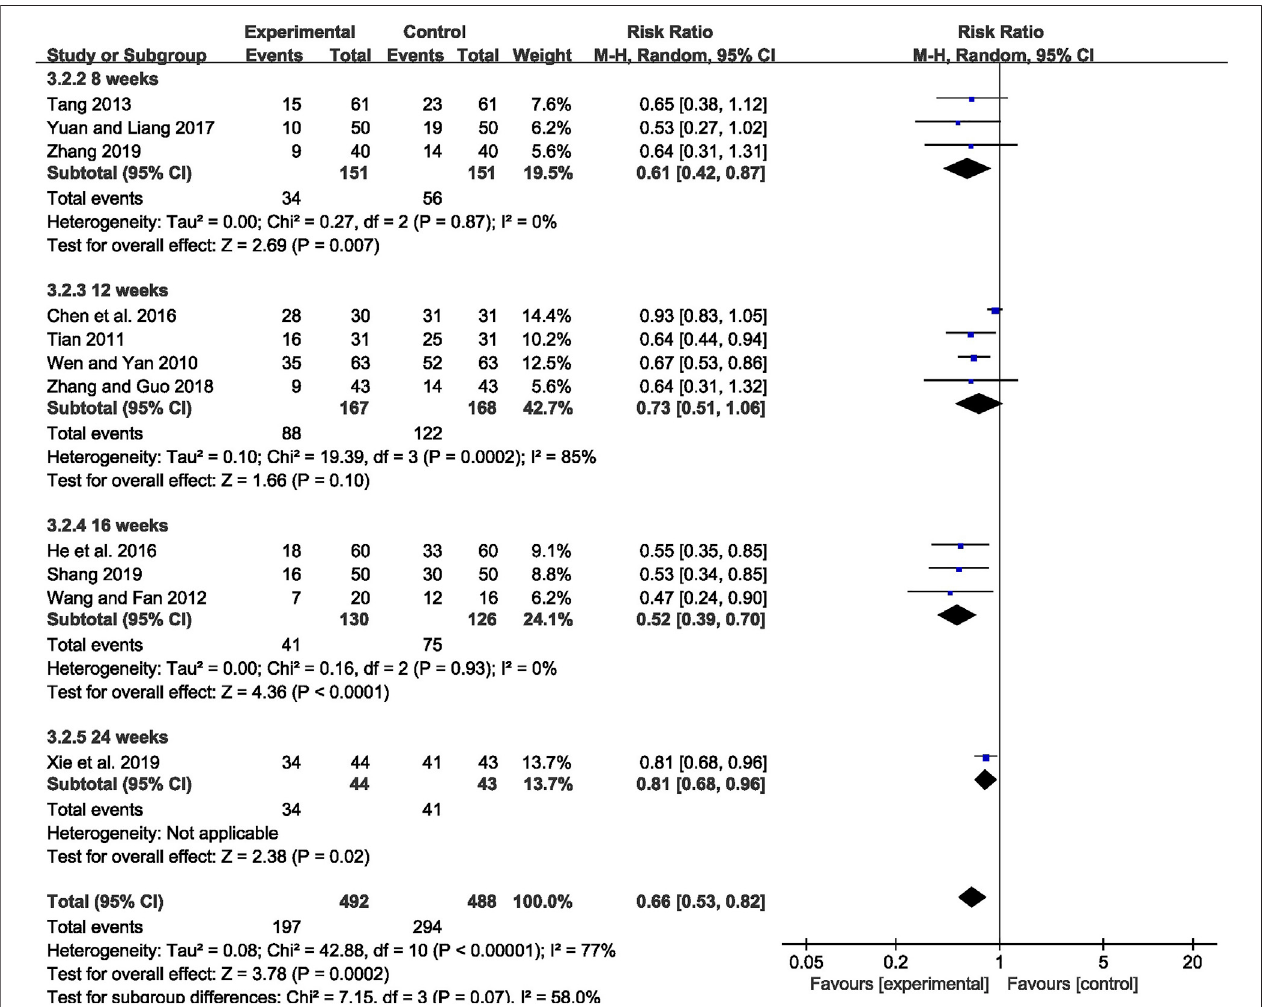
FIGURE 6 | Forest plot displaying the results of subgroup analysis of CHM+AEDs vs. AEDs for abnormal rate of EEG in patients with IE according to various treatment duration.